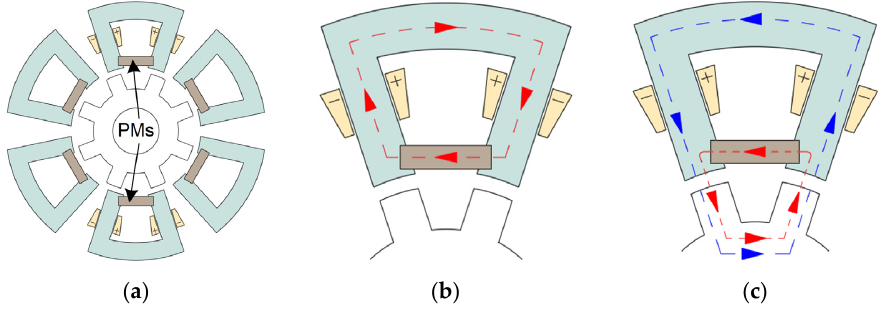
Figure 22. Proposed new type of 12/8 HESSRM. ( a ) is the basic structure; ( b , c ) are the flux paths without phase winding excited and with phase winding excited, respectively.